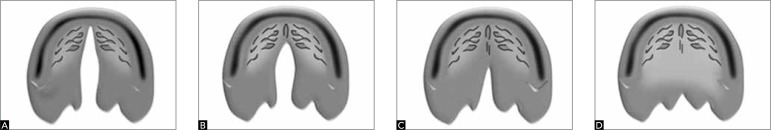
Complete cleft palate invariably extends from the incisive foramen to the uvula
(A). Incomplete cleft palate involves the posterior region of the palate without
reaching the incisive foramen (B); affects the soft palate and part of the hard
palate (C); or may affect only the soft palate (D).